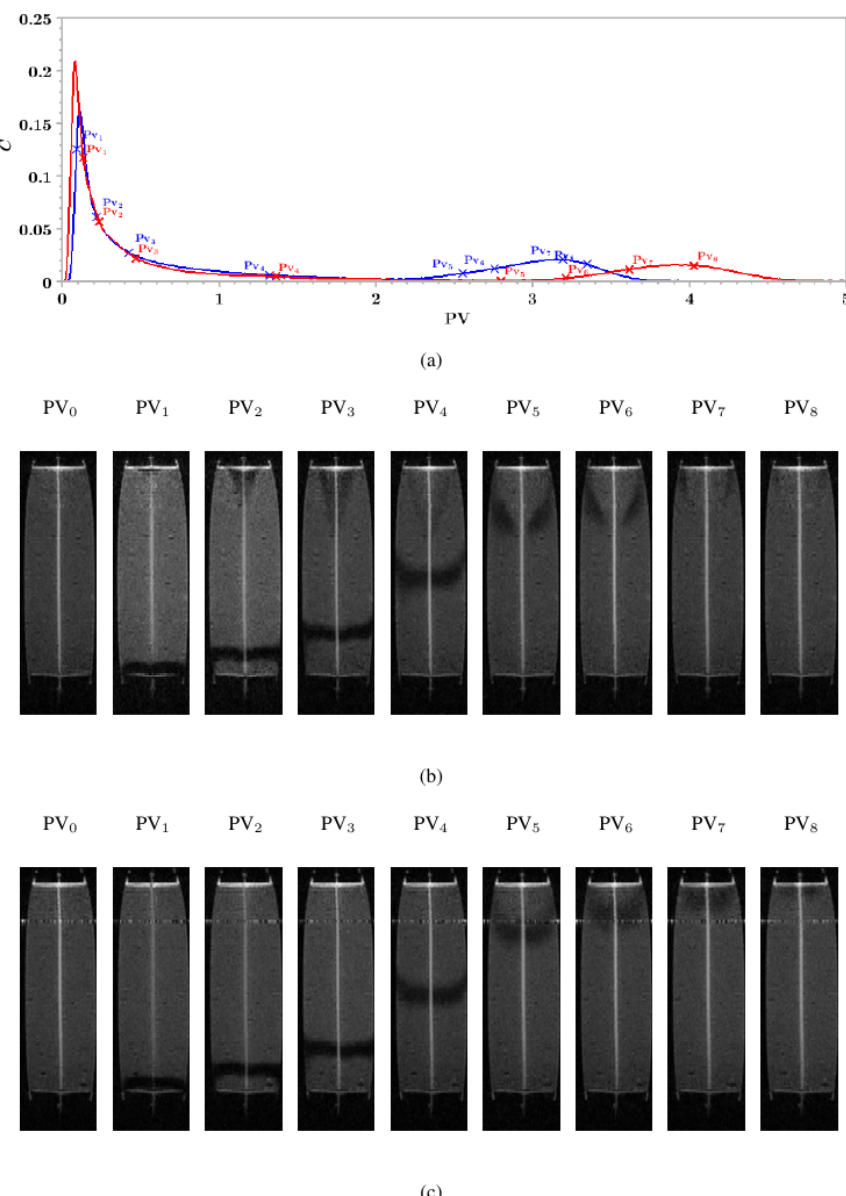
Figure 4. (a) GdCl 3 experimental BTCs measured at the outlet of column B (macroporous column with a permeable macropore) with (blue curve) and without (red curve) an outlet filter. MRI images taken throughout the elution as a function of the number of pore volumes, PV, for column B, with the outlet filter (b) and without the outlet filter (c) . Pores volumes corresponding to the time average at which each image has been acquired are reported in (a) . The GdCl 3 tracer solution was injected at the bottom of the column and appears dark within the column in the MRI